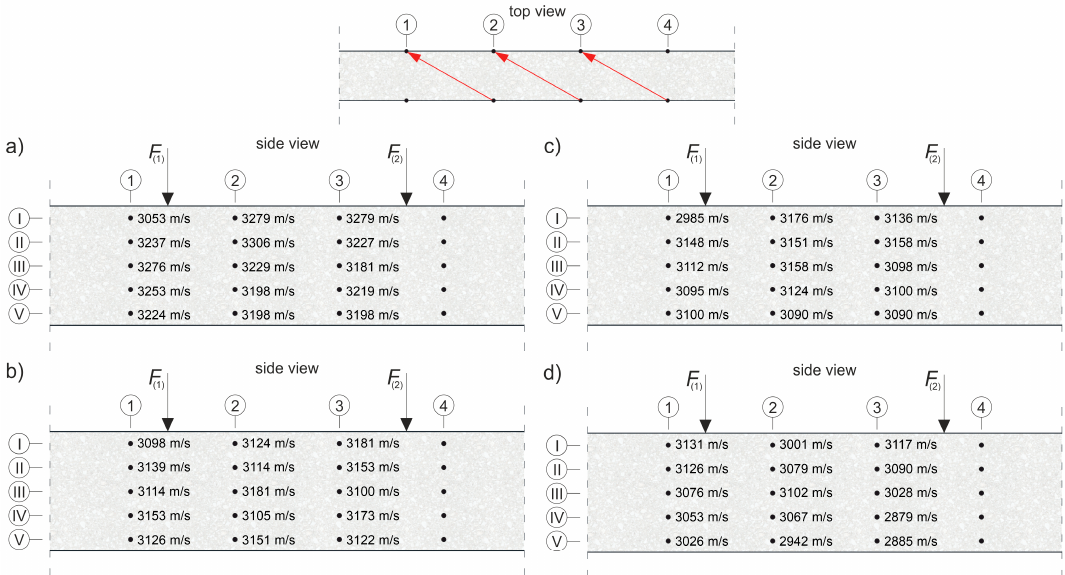
Figure 32. Velocities of the longitudinal waves in beam #3 propagating between the sending and receiving points situated diagonally with one point offset in the right direction, before: ( a ) stage 1, ( b ) stage 2, ( c ) stage 3, ( d ) stage 4.